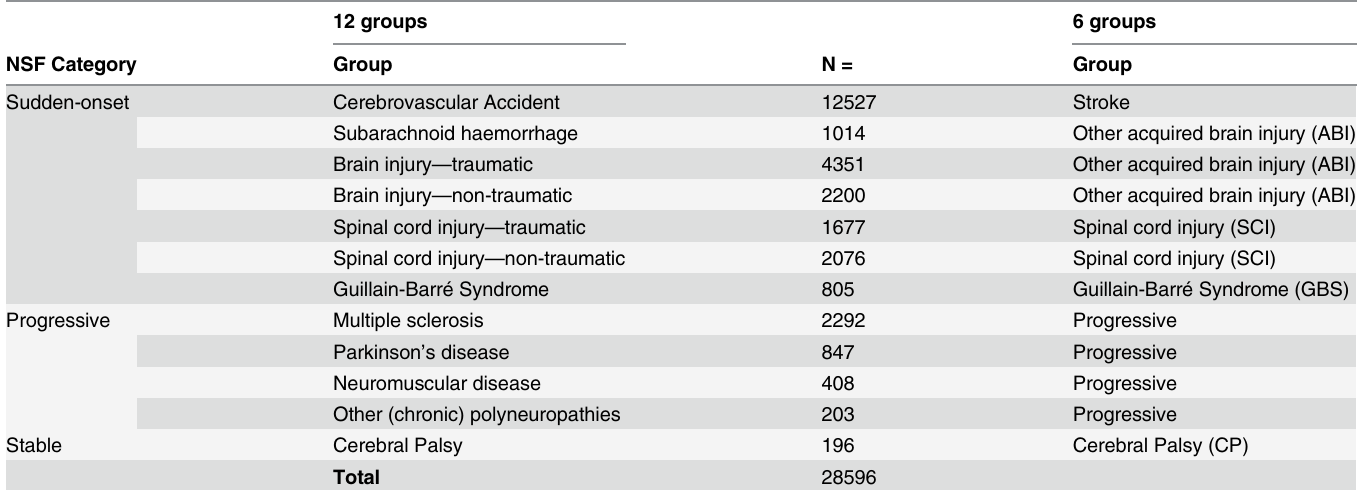
Table 2. Grouping for